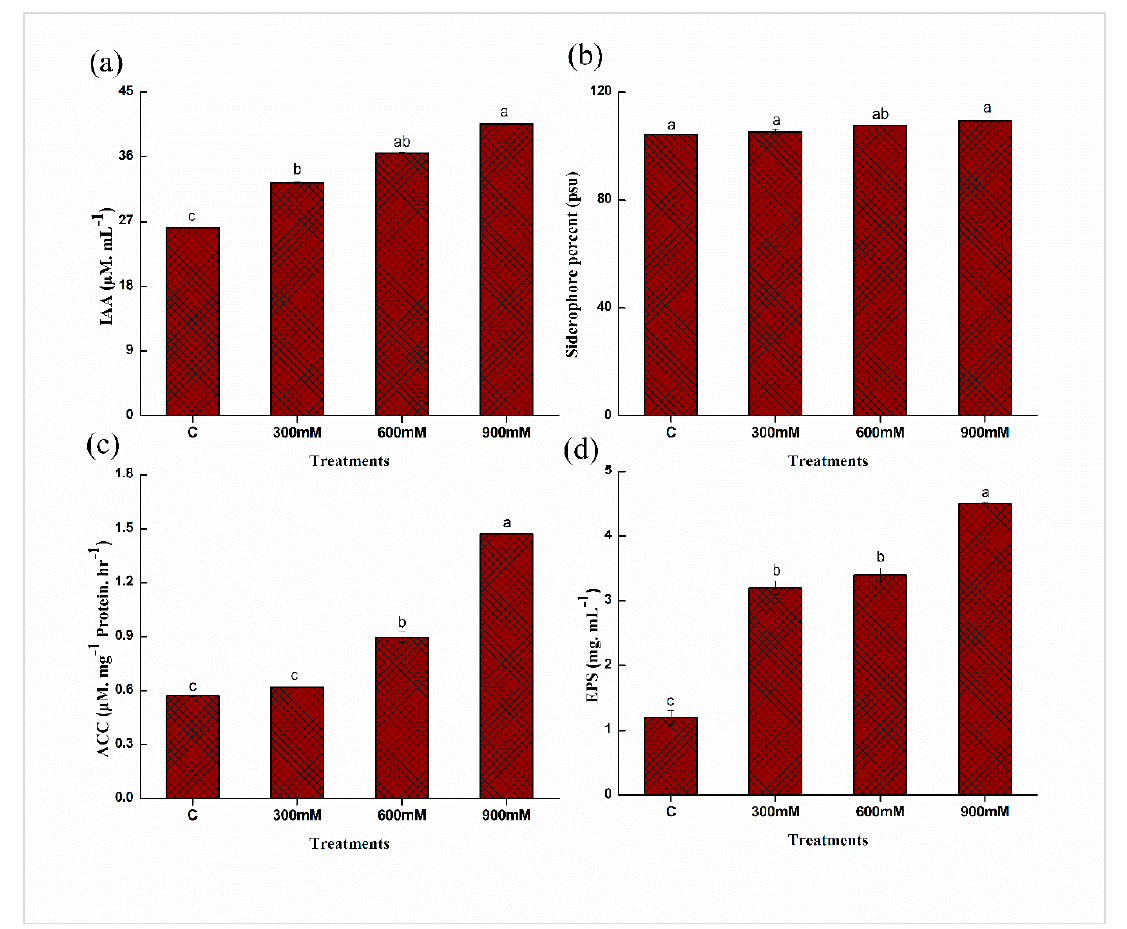
Figure 3. Quantitative estimation of PGP traits of E. cloacae PM23: ( a ) Indole-3-acetic acid (IAA) ( b ) Siderophore ( c ) ACC deaminase (ACCD) ( d ) Exopolysaccharides (EPS). The a, b, c inside the figure (on top of the bar graphs) refer to the same meaning in the caption.